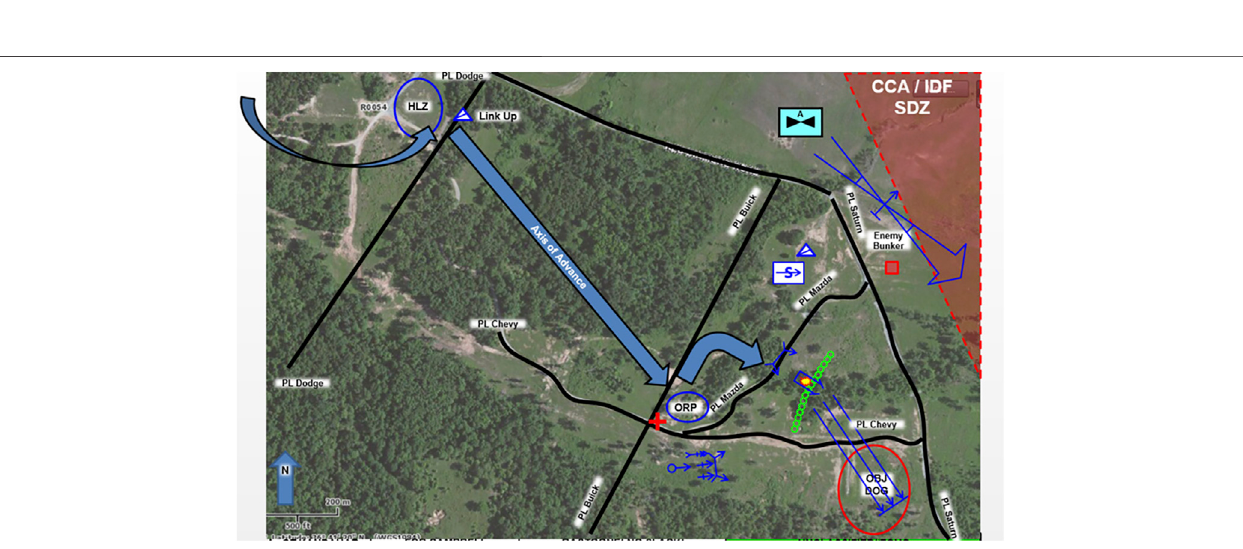
FIGURE 2 | The Above Represent the Visualizations That Each Participant Experiences: Tablet, Sand table, and HoloLens ™ .